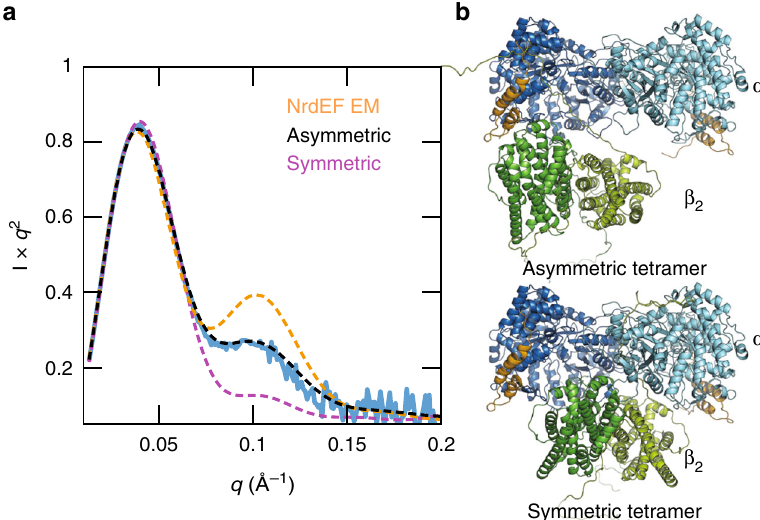
Fig. 5 The active NrdEF structure is a fl exible α 2 β 2 . a SEC – SAXS of a stoichiometric mixture of C382S holo-NrdE and NrdF under activating conditions (1 mM ATP, 250 µ M TTP) revealed a predominant species (experimental pro fi le shown in blue) with a molecular weight estimate 39 of 246 kDa, consistent with an α 2 β 2 species (actual MW of 243 kDa). Structural modeling was performed in AllosMod-FoXS 40 using three different α 2 β 2 starting models. Using a symmetric α 2 β 2 docking model 18 as a starting model underestimated the shoulder observed in the mid- q region (purple dash; χ 2 = 20.43), suggesting that the solution structure is more open. In contrast, the expanded α 2 β 2 starting model derived from the ASU of the NrdEF cryo-EM structure (Fig. 2e, right) overestimated the shoulder (orange dash; χ 2 = 18.55), suggesting that the subunits are closer together in solution under activating conditions. An asymmetric α 2 β 2 starting model based on an S. typhimurium structure (PDB: 2BQ1) 33 yielded the best- fi t conformer (black dash; χ 2 = 2.25). SAXS pro fi les are shown in Kratky representation ( q vs. I x q 2 ) to emphasize mid- q features. b Best- fi t models of the asymmetric α 2 β 2 (top) and symmetric α 2 β 2 (bottom). Source data are provided as a Source Data fi